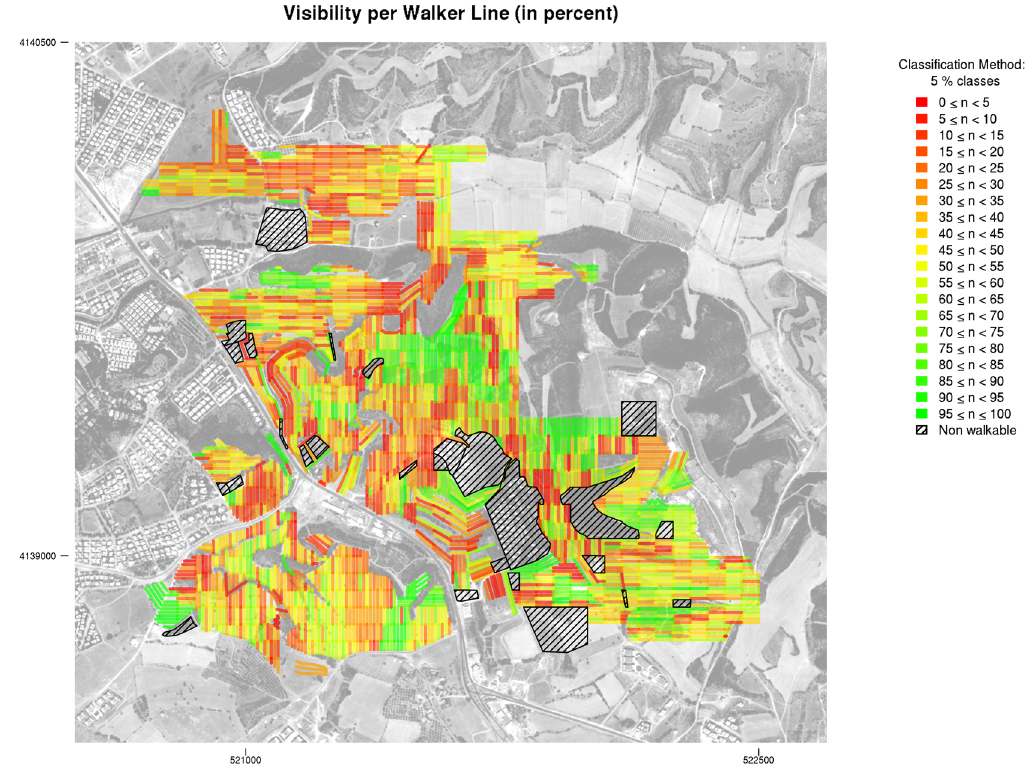
Figure 3. A map plot generated using R, based the 2015 data, showing the ground-surface visibility of each walker. (Base satellite image: WorldView-2, ©